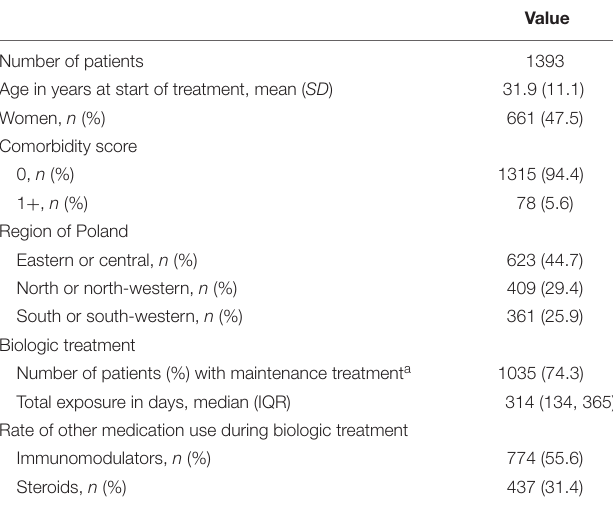
TABLE 1 | Characteristics of patients at the start of the first biologic